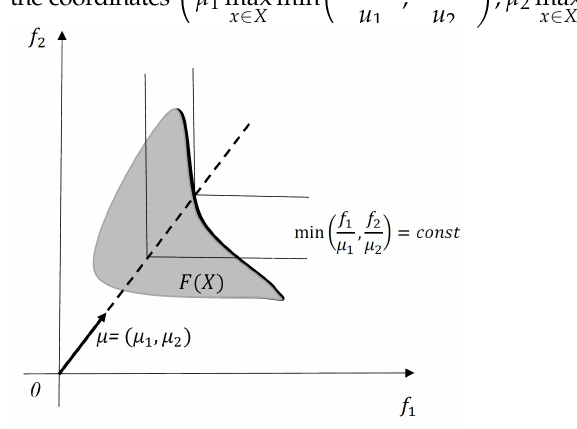
Figure 1. Germeier’s scalarization in the two-criteria max